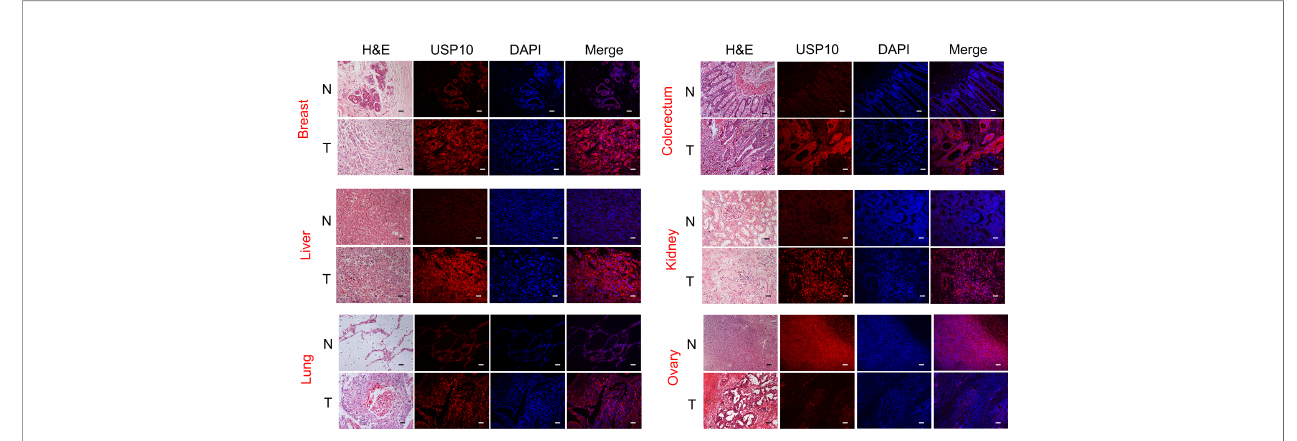
FIGURE 2 | The protein level of USP10 in different types of cancer. Representative images of H&E stained normal and tumor slides (left 1st). Immuno fl uorescence staining analysis (left 2nd to 4th) showing that an evident fl uorescent signal in the tumor tissue sections compared with that in the control group. However, in ovarian cancer, normal tissue has a stronger fl uorescent signal than tumor tissue. All scale bars = 50 m m. H&E, hematoxylin-eosin staining. N, normal tissues; T, tumor